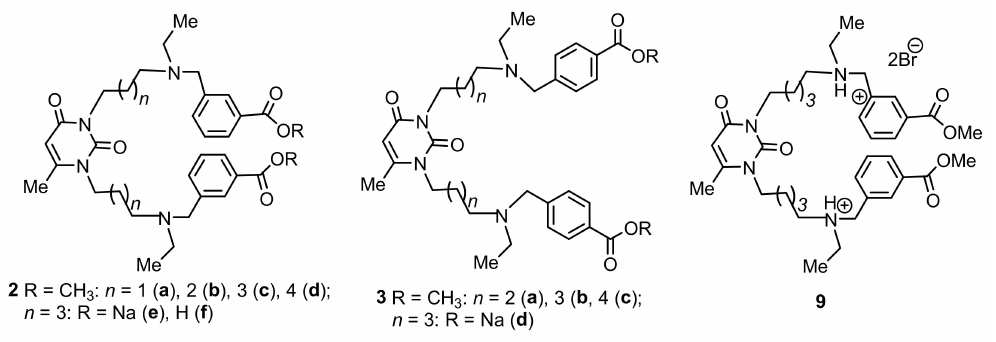
Figure 2. Structures of compounds synthesized with benzoate